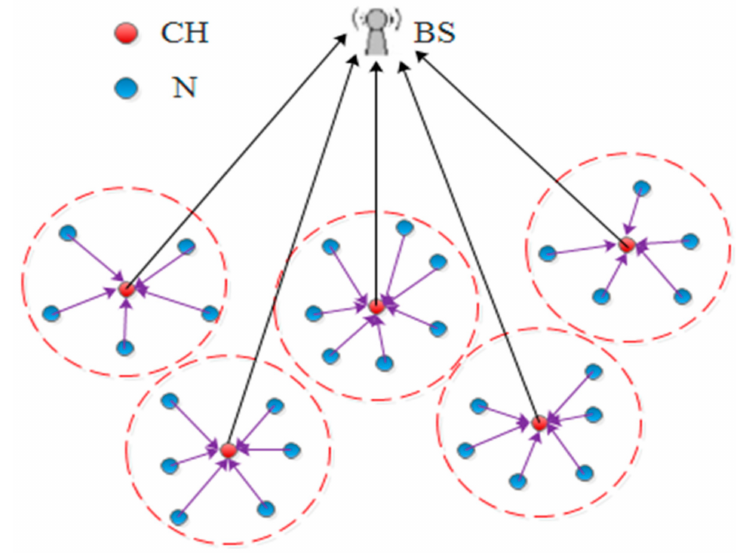
Figure 1. The topology of Wireless Sensor Networks (WSN) using the Low Energy Adaptive Clustering Hierarchy (LEACH)